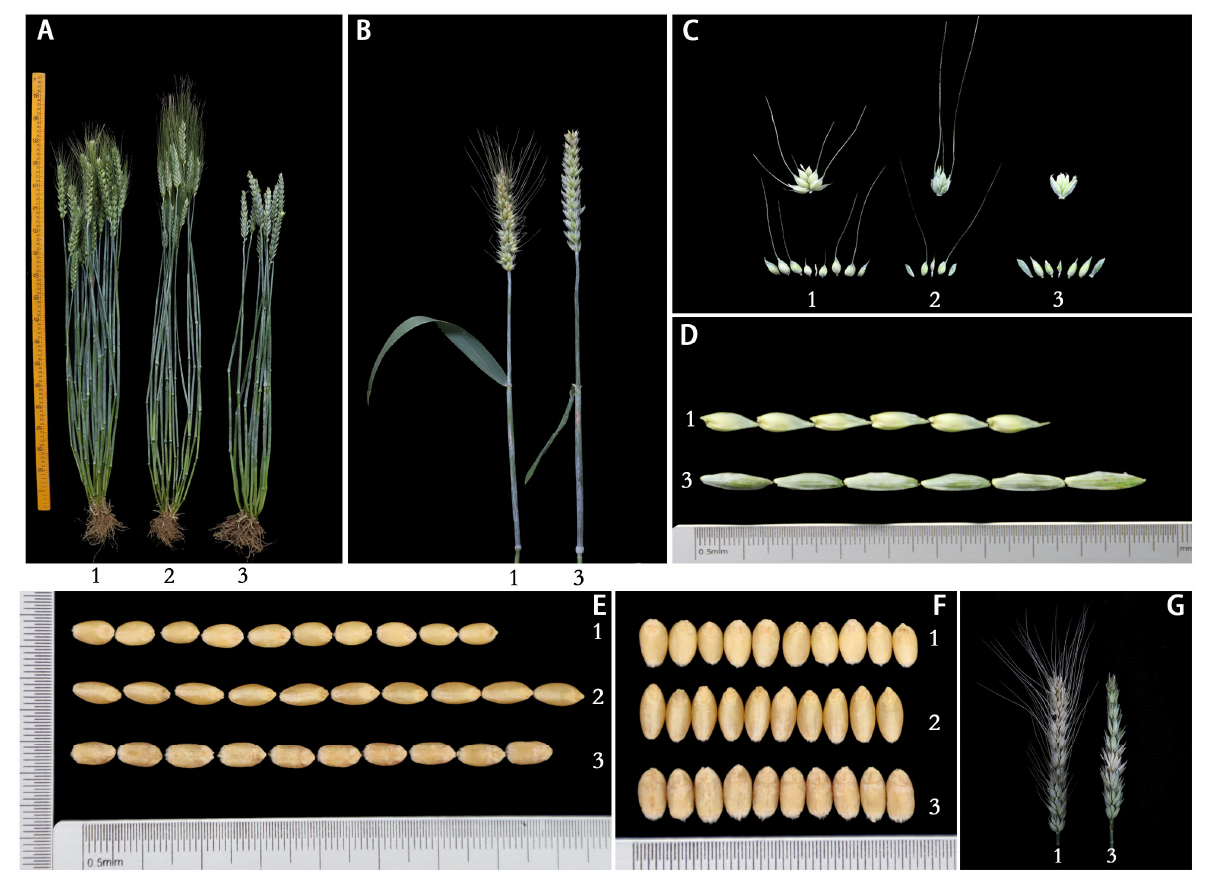
Figure 1. Agronomic traits of 20JH1155 and its wheat parents. The materials in the fi gures are (1) common wheat 7182; (2) T. durum Trs-372; (3) 20JH1155. ( A ) Adult plant. ( B ) Spike and peduncle. ( C ) Spikelet, glume, and lemma. ( D ) Glume. ( E ) 10-seed length. ( F ) 10-seed width. ( G ) FHB resistance to F. gPH1 of 7182 and 20JH1155.